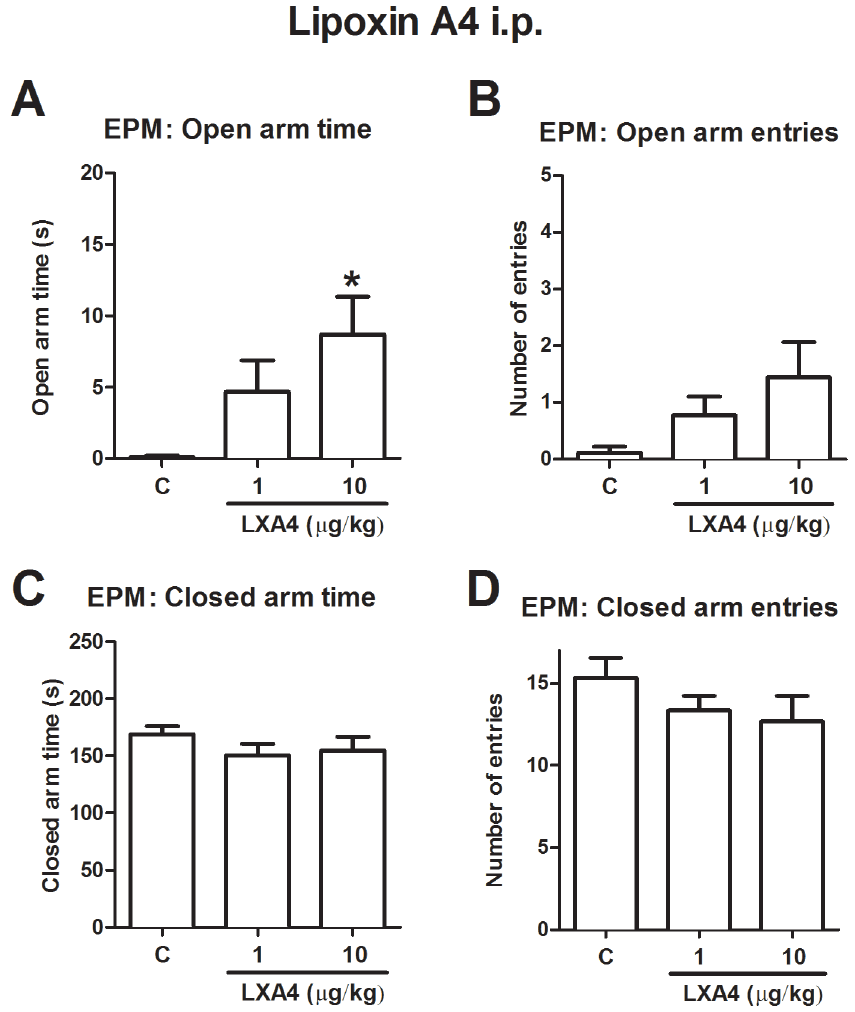
Figure 4. Anxiolytic-like effect of exogenous Lipoxin A 4 in the EPM test. After a single dose of Lipoxin A 4 (10 ug/kg, i.p.), adult Swiss mice showed a significant increase in (A) open arm time. No difference was observed in (B) entries in open arms, (C) time in closed arms or (D) entries in closed arms. Data are presented as mean 6 SEM (n=9). Statistical Analysis was performed by ANOVA followed by Newman-Keuls post hoc test. *p , 0.05 vs vehicle.